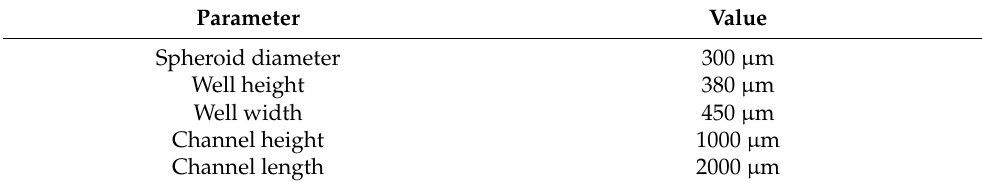
Table 1. Values of the geometrical parameters used in computational